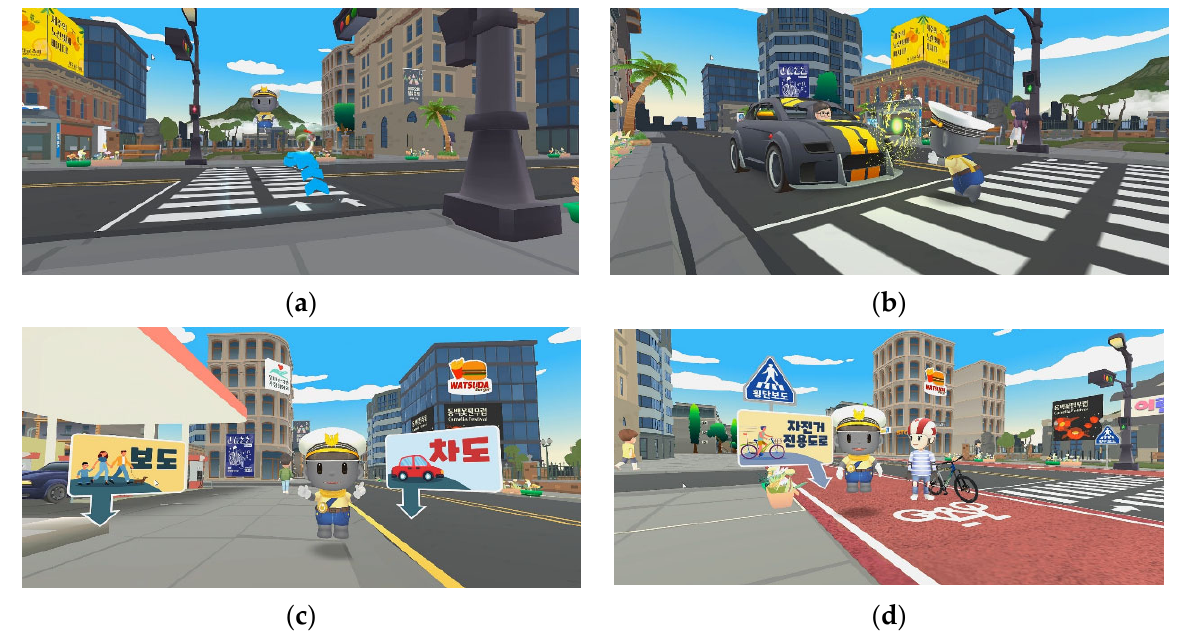
Figure 3. Representative VR image used in the study. ( a ) The children are instructed to follow the direction of the arrow. A virtual police officer explains ( b ) how to cross the road, ( c ) the driveways and sidewalks, and ( d ) the presence of bicycles on the bike path requiring caution.